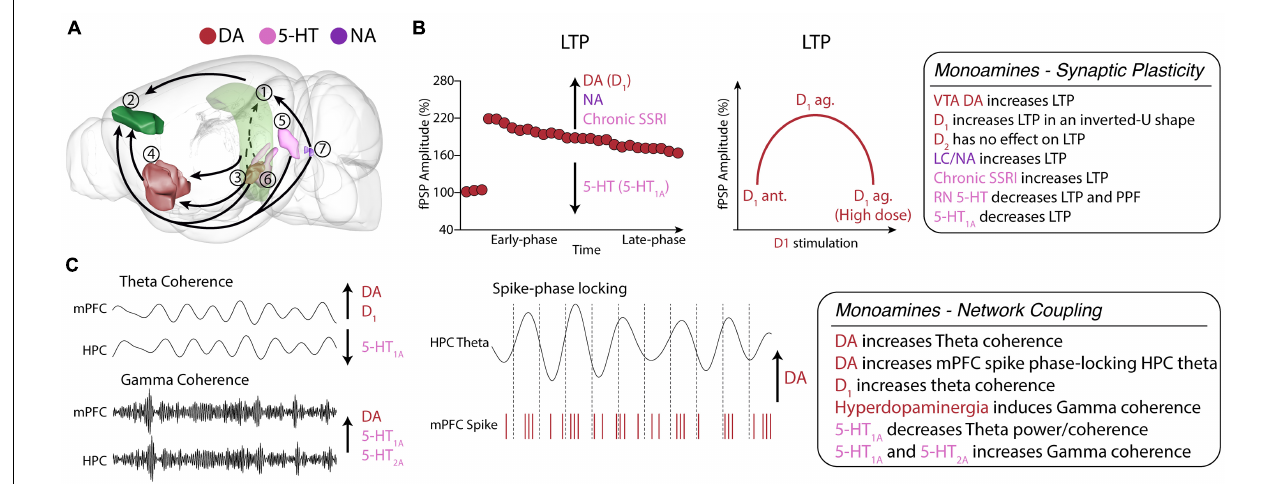
FIGURE 3 | Monoamine neuromodulation of HPC-mPFC communication. (A) HPC-mPFC pathway and monoaminergic circuits. (1) Hippocampus CA1; (2) Prelimbic prefrontal cortex; (3) Ventral tegmental area; (4) Nucleus accumbens; (5) Dorsal raphe nuclei; (6) Median raphe nuclei; (7) Locus coeruleus . Red: main dopaminergic anatomical structures; Purple: main noradrenergic anatomical structures; Pink: main serotoninergic anatomical structures (brain sites adapted from the Brain Explorer, Allen Institute). (B) HPC-mPFC LTP is positively modulated by DA, NA, and chronic SSRI, while 5-HT decreases LTP. In particular, D 1 activation affects LTP in an inverted U-shaped dose dependence, providing a fine-tune functional regulation in the HPC-mPFC pathway. (C) In HPC-mPFC communication, D 1 and 5-HT 1A receptors induce opposite effects in theta coherence, however, both increase gamma coherence. DA, dopamine; 5-HT, serotonin; NA, noradrenaline; SSRI, selective serotonin reuptake inhibitor; LTP, long-term potentiation; LTD, long-term